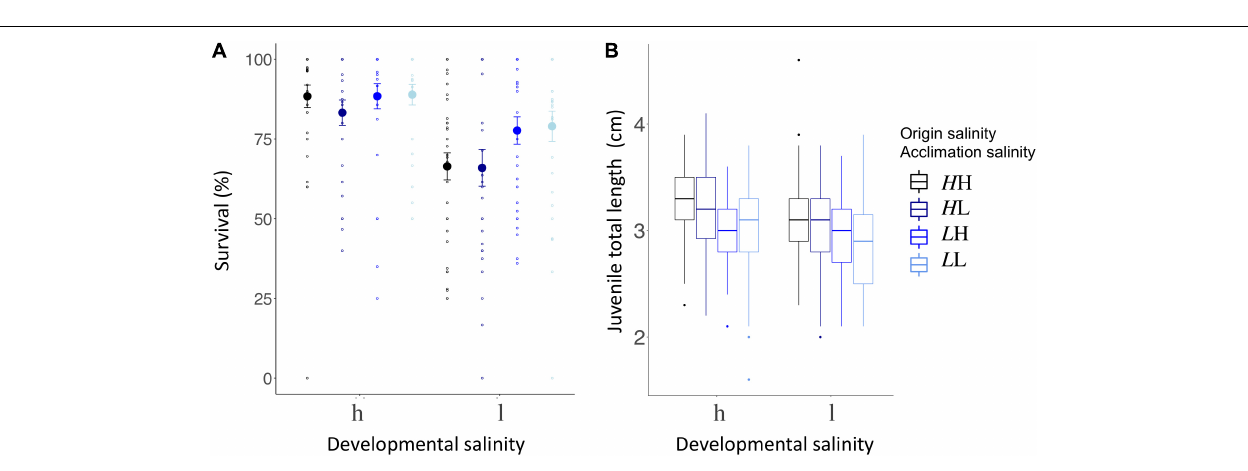
FIGURE 6 | Juvenile life history parameters (A) survival rate (%), (B) body length (cm). (A) The percentage of juveniles surviving the first 10 days post-hatch (%) are plotted on the y -axis. The x -axis indicates the developmental salinity after hatching (h – high/15 PSU, l – low/7 PSU). Italic letters and colors specify the origin salinity of the parental generation ( H : 15 PSU, black and dark blue; L : 7 PSU blue and light blue). The 2nd letter indicates the acclimation salinity in the lab (H: 15 PSU, black and blue; L: 7 PSU, dark and light blue). (B) Juvenile size (cm) 10 days post hatch is plotted on the y -axis. Labeling and color code correspond to panel (A)